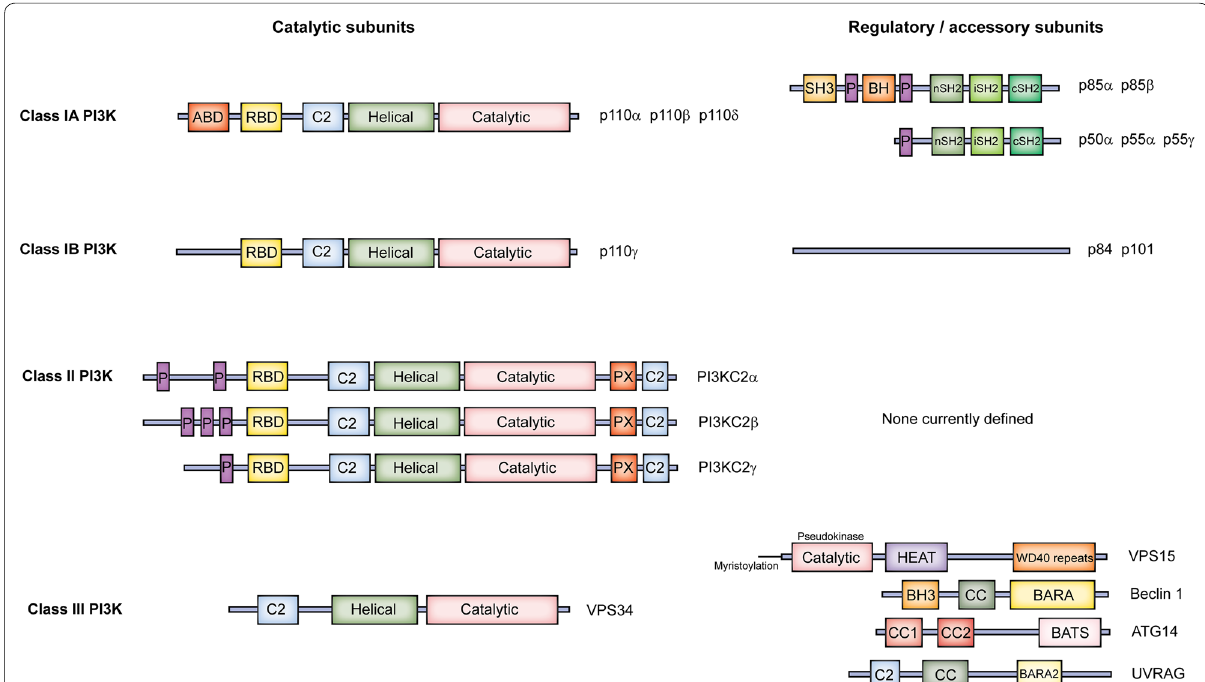
Fig. 1 Domain organisation of the PI3Ks. Class I, II and III PI3K catalytic subunits share a core region consisting of a C2 domain, helical domain and kinase domain, but differ in other regions of the protein. While the domain structure of the Class IA regulatory subunits is well defined, the Class IB regulatory subunits have no clearly-defined domain structure, while no regulatory subunits have been reported for the Class II PI3Ks. The Class III PI3K, VPS34, associates with a range of accessory proteins to form at least two distinct